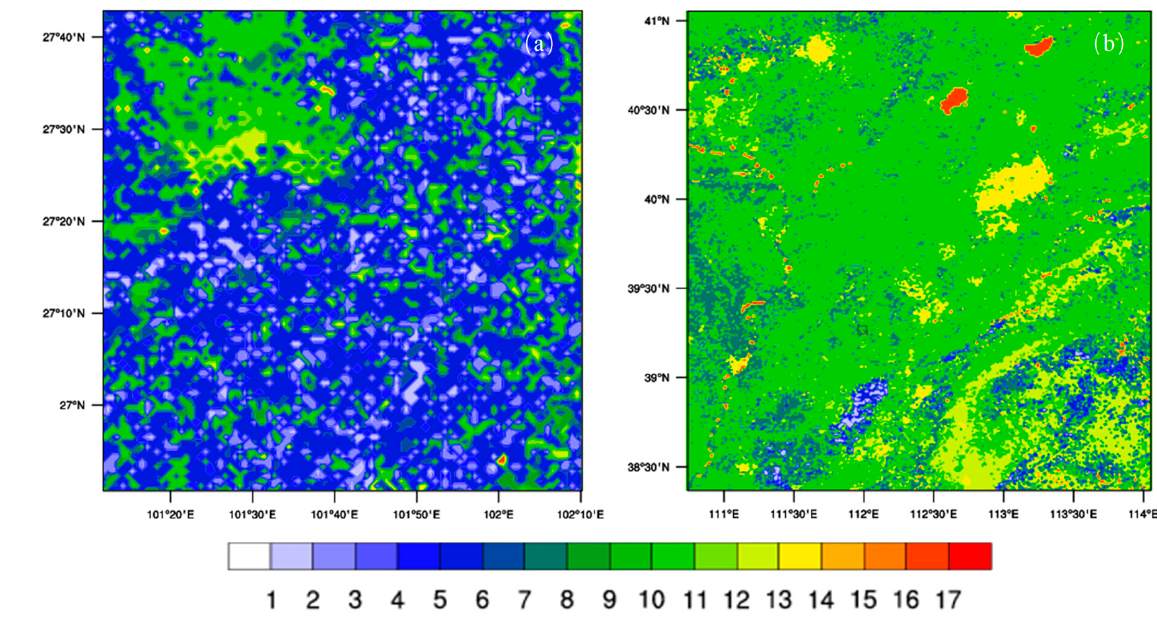
Figure 3. Land use categories at ( a ) site 1 and ( b ) site 2. Table 1. Land use categories.